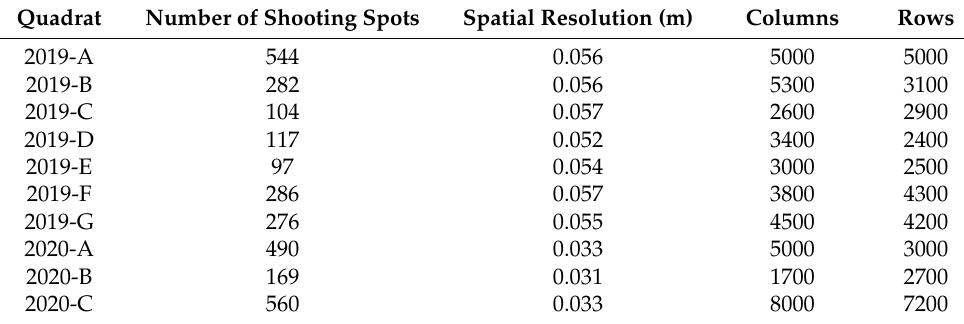
Table 1. The specifications of the UAV orthophoto datasets. Quadrat Number of Shooting Spots Spatial Resolution (m) Columns